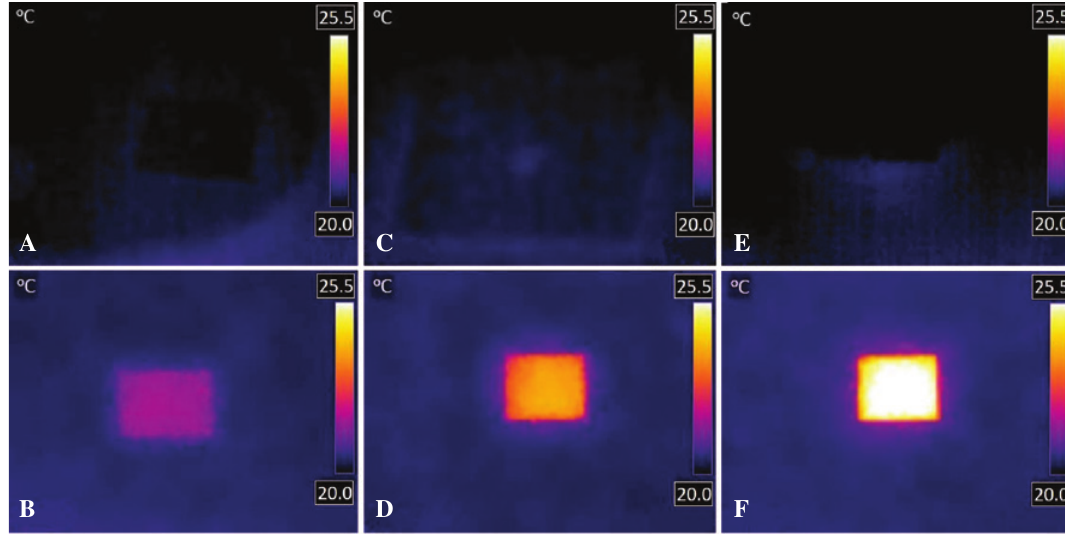
Figure 6: Experiments for photothermal conversion. (A, C, E) Temperature distribution of the fractal structures K1–K3 without Au film as a reference. (B, D, F) Temperature distribution of the fractal structures K1–K3 with a 10-nm-thick Au film. The active region containing fractal geometry is inside the dashed box. Room temperature is kept at 20 °